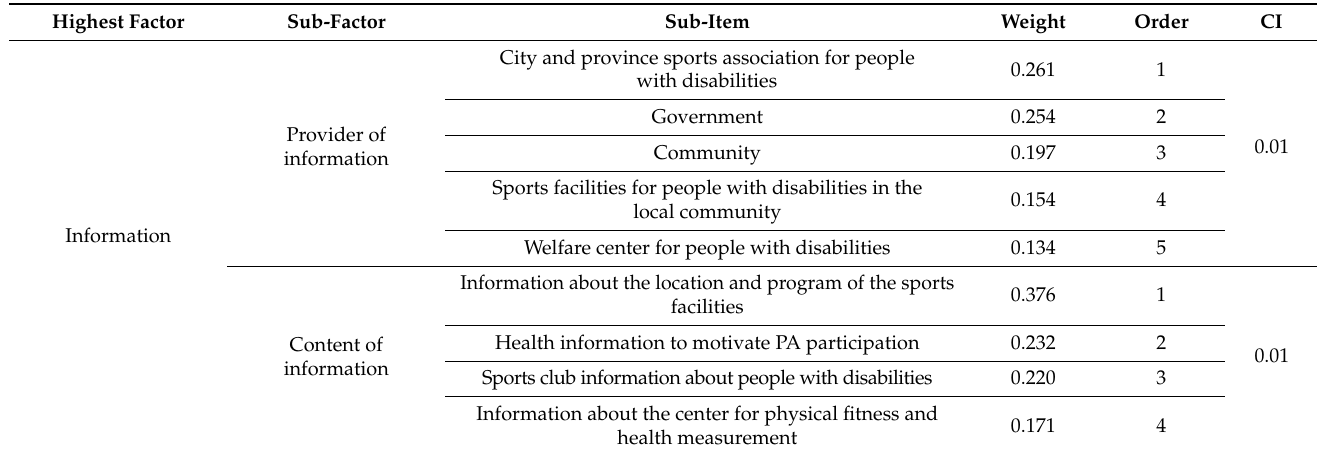
Table 13. Results of the relative importance of H4 by the information in H3.